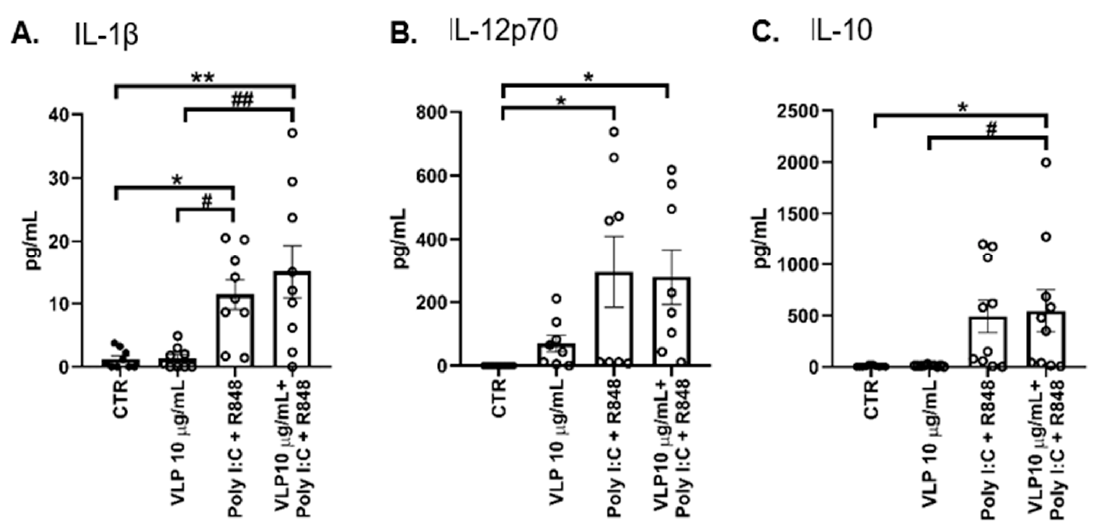
Figure 3. DCs’ release of cytokines into the medium when stimulated with VLPs. DCs were treated with 20 µ g/mL Poly I:C and 2.5 µ g/mL R848, or 10 µ g/mL VLPs, or VLPs plus 20 µ g/mL Poly I:C and 2.5 µ g/mL for 24 h. The concentration of ( A ) IL-1 β , ( B ) IL-12p70, and ( C ) IL-10 was determined through ELISA. Control cells (CTR) were not stimulated. Each column represents the mean ± SEM of at least eight independent experiments (each point corresponds to an individual donor). * p < 0.05, ** p < 0.01 relative to CTR; # p < 0.05, ## p < 0.01 among the other comparisons. VLP: virus-like